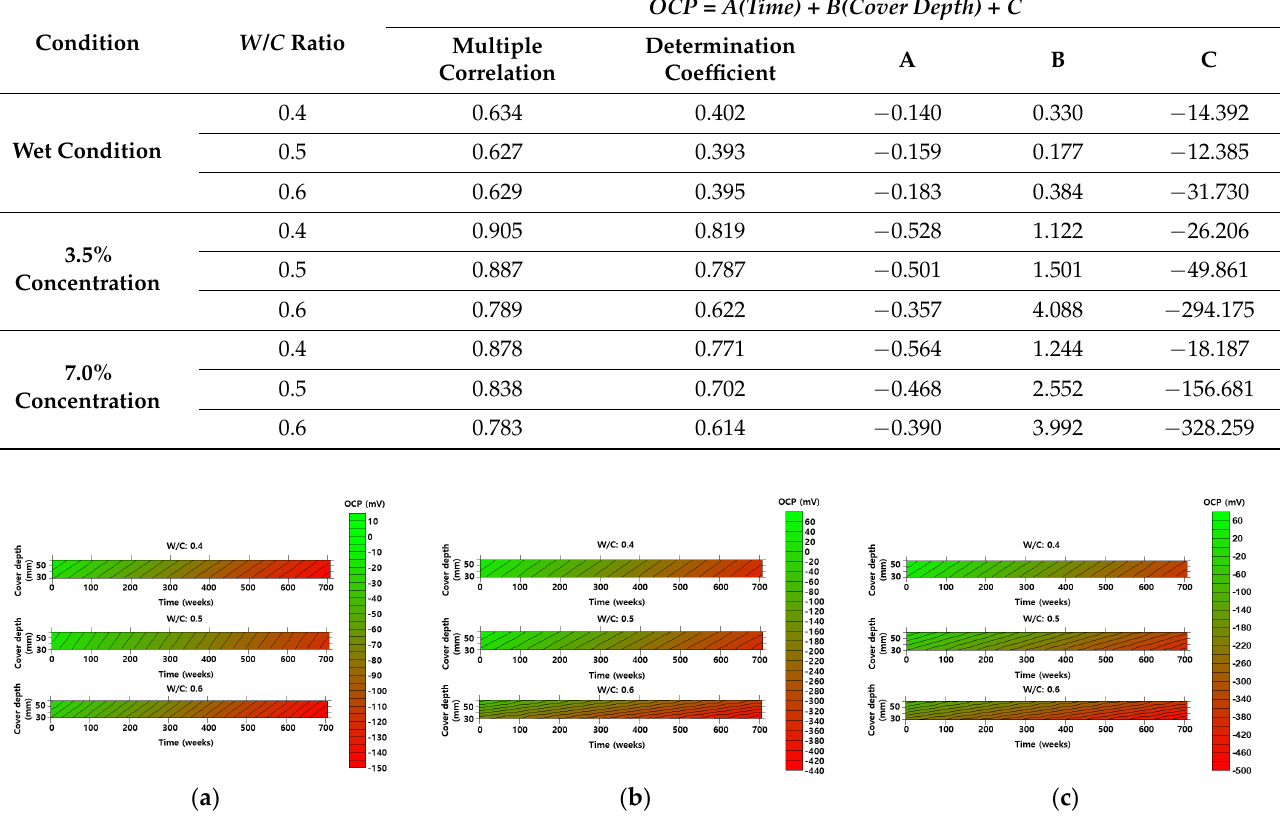
Figure 14. Open-circuit potential (OCP) contour with corrosion parameters: ( a ) wet condition, ( b ) 3.5% concentration, and ( c ) 7.5% concentration.